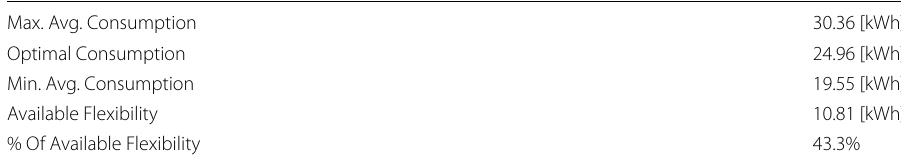
Table 5 Generated flexoffers average consumption results